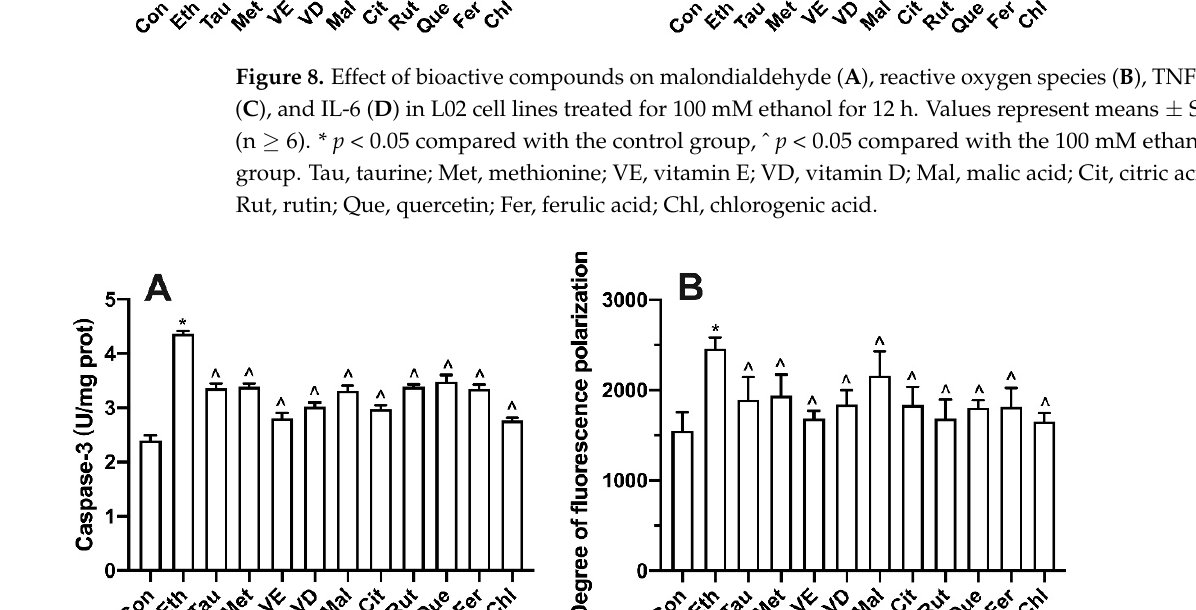
Figure 8. Effect of bioactive compounds on malondialdehyde ( A ), reactive oxygen species ( B ), TNF- α ( C ), and IL-6 ( D ) in L02 cell lines treated for 100 mM ethanol for 12 h. Values represent means ± SD (n ≥ 6). * p < 0.05 compared with the control group, ^ p < 0.05 compared with the 100 mM ethanol group. Tau, taurine; Met, methionine; VE, vitamin E; VD, vitamin D; Mal, malic acid; Cit, citric acid; Rut, rutin; Que, quercetin; Fer, ferulic acid; Chl, chlorogenic acid.